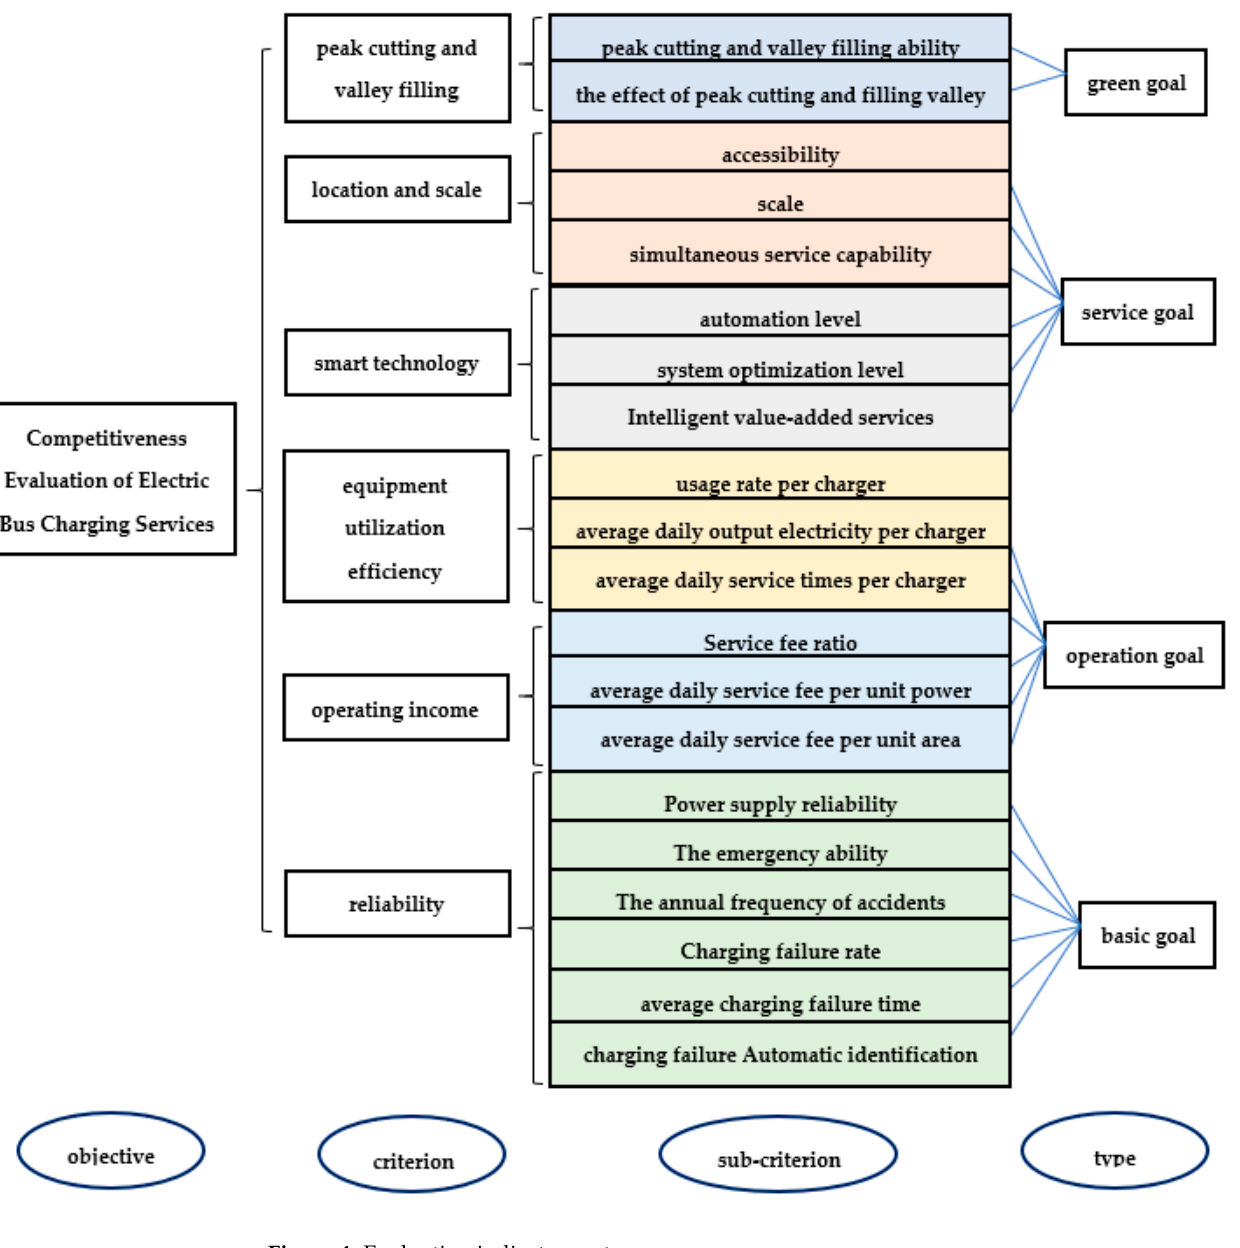
Figure 4. Evaluation indicator system.